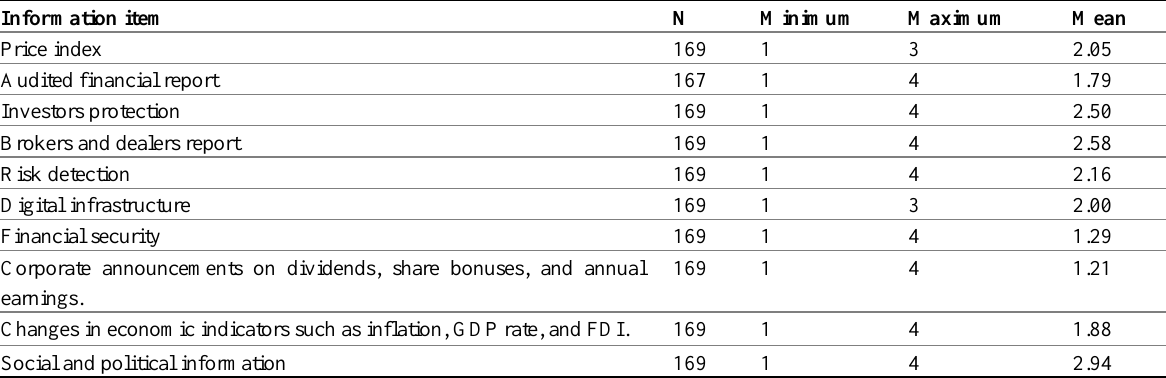
Table 3: The information offered by DSE